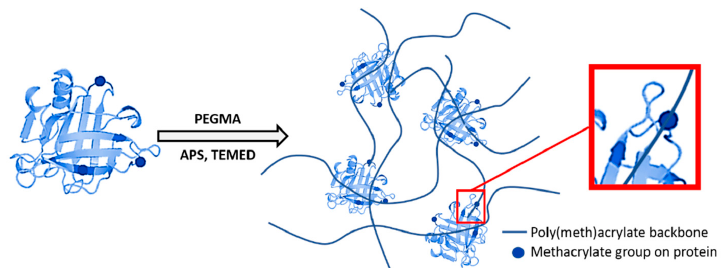
Figure 2. Copolymerization of the methacrylated protein with PEGMA in presence of initiator APS and catalyst TEMED (adapted from Chan et al. [24]).